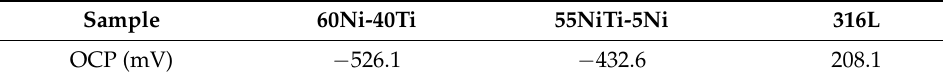
Table 4. The stable open-circuit potential of coatings and the substrate.